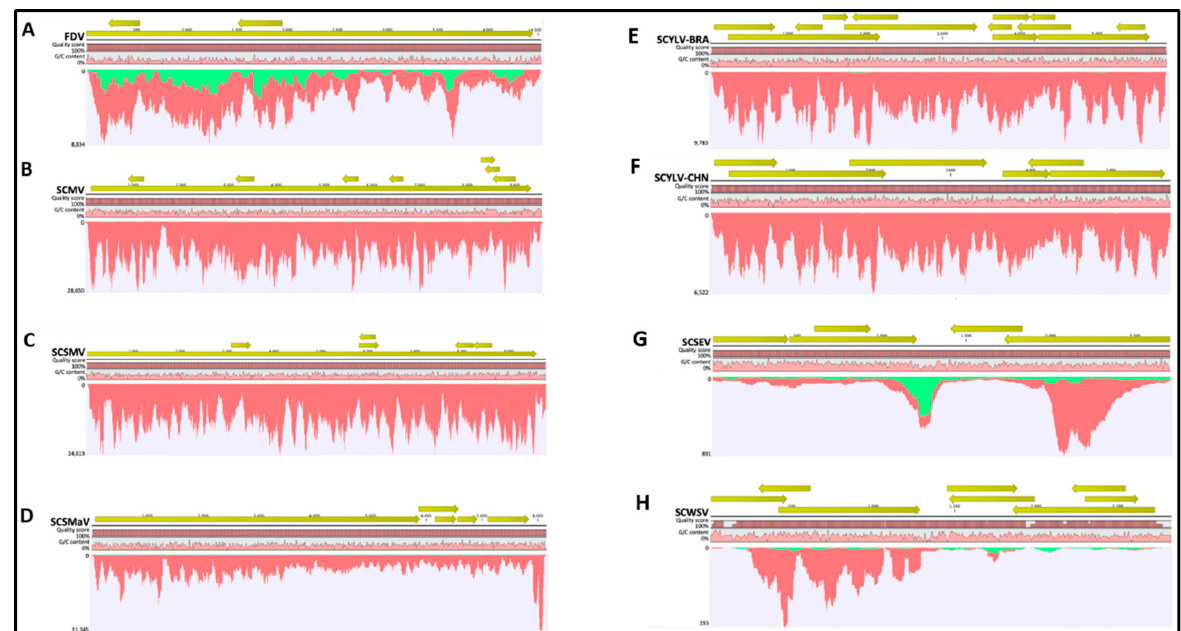
Figure 4. Genome coverage of RNA ( A – F ) and DNA ( G , H ) viruses from sugarcane specimens sampled in the spring. Sequencing reads from RNA and DNA viruses were mapped to best hit reference genomes using CLC Genomics Workbench at default parameters. Shown in each panel are open reading frames, consensus sequence, sequence quality score, G/C content, and coverage graph. The SCYLV-BRA genotype is represented by sample P1. The SCYLV-CHN genotype is represented by sample P6. Colors in the map denote the single reads mapped in their forward (green) and reverse (red) directions. ORFs are denoted by greenish yellow arrows.